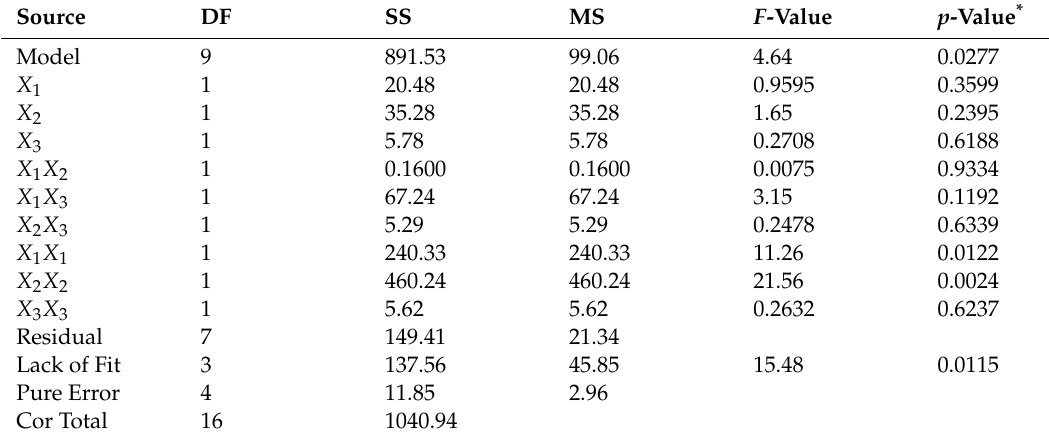
Table 4. Analysis of variance (ANOVA) of fitted quadratic polynomial model for D-cyphenothrin degradation.